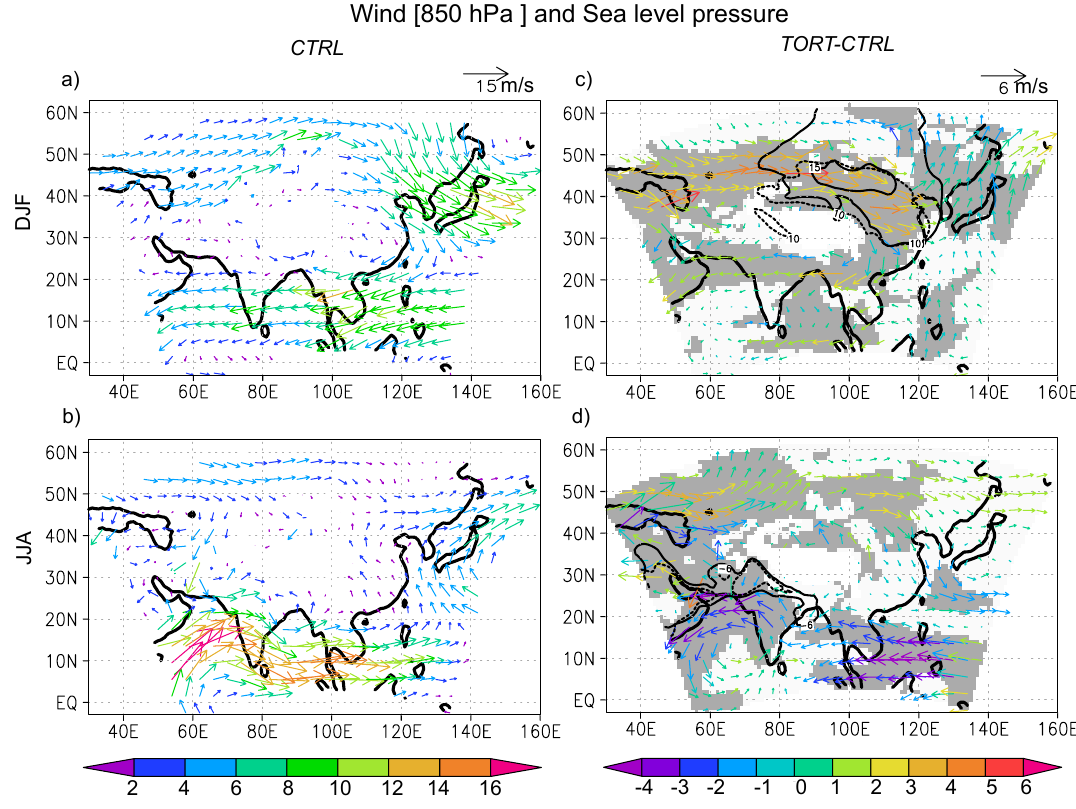
Fig. 5. Winter (DJF) and summer (JJA) wind (ms − 1 ) at 850hPa. (a, b) CTRL, (c, d) difference between TORT and CTRL. The grey shaded areas in (c, d) indicate the regions where either the zonal or the meridional wind anomalies are significant with a Student’s t-test ( p = 0 . 05). The contour lines represent the sea level pressure (hPa) anomalies to the domain average in CTRL (solid) and TORT (dashed). The colour of vectors denotes the absolute wind speed in (a, b) and the difference of wind speed in (c, d)